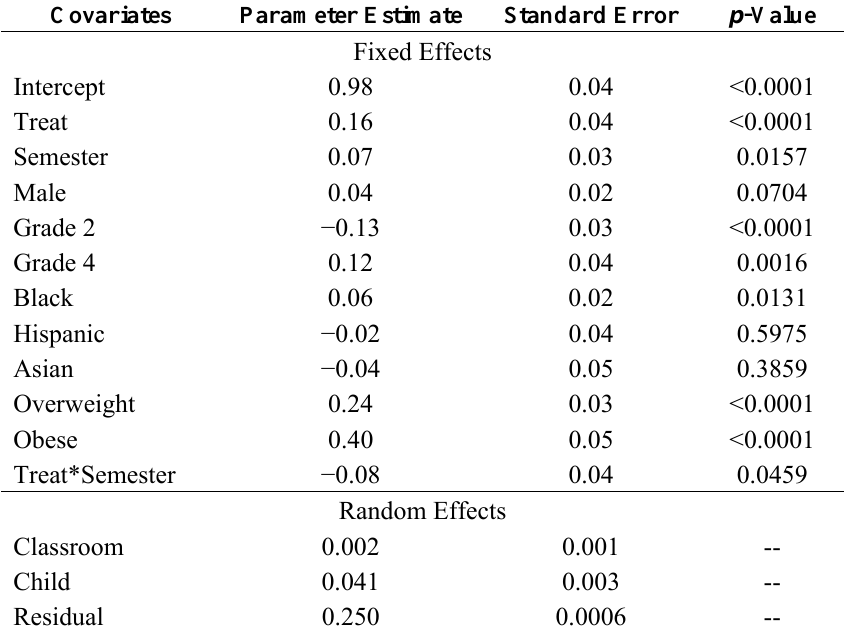
Table 4. Effects of treatment and other covariates on EE from fitting a linear mixed effects model to the